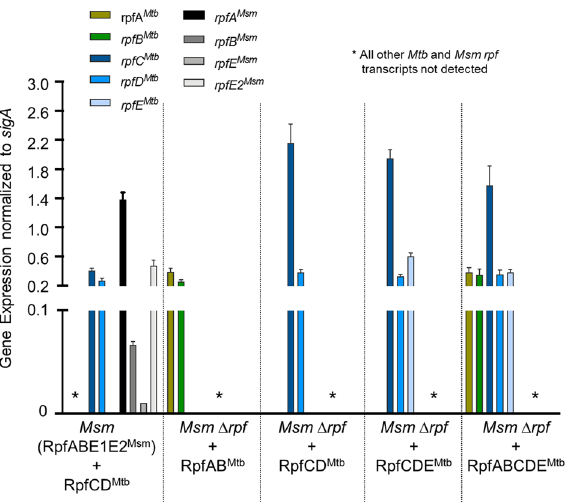
Figure 2. Assessment of Mtb and Msm rpf gene expression in recombinant strains. Transcriptional analysis was carried out on recombinant strains of Msm and the cognate parent strains. In all strains shown, transcriptional analysis was carried out for all five Mtb and four Msm rpf genes. Where these genes were deleted, no transcripts were detected. Transcript levels were assessed in each strain when axenic cultures reached mid-exponential growth (OD 600nm ~ 0.6). Gene expression was normalized against Msm sigA transcript levels. Data are representative of three independent biological repeats. Graph was generated using Graphpad Prism software.